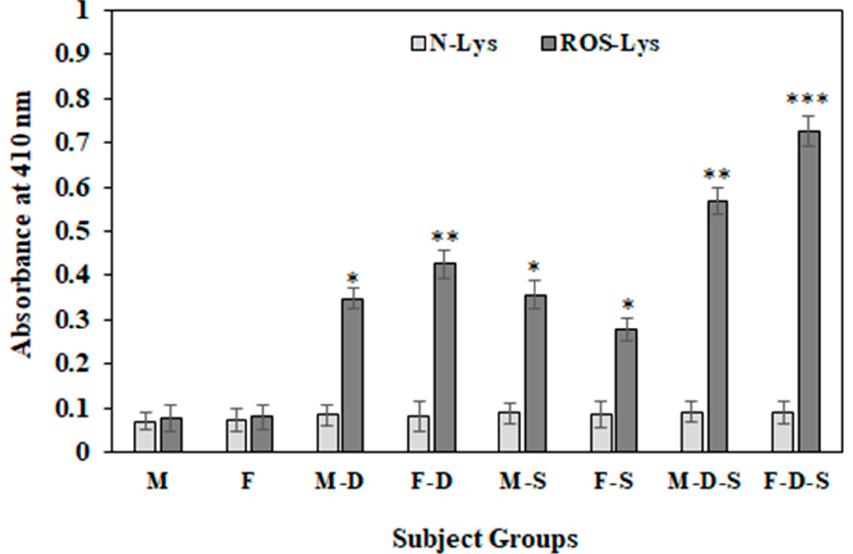
Figure 3. Detection of serum autoantibodies against native and ROS-BSA using direct binding ELISA. ELISA plates were coated with 5 µ g/mL antigens. Each group consisted of 15 subjects. Values are given as mean ± SD. The t test was adopted for comparison between the two groups, and significance is defined as * p < 0.05, ** p < 0.01, *** p < 0.001. The comparison of autoantibodies against ROS-BSA between group M with groups M-D, M-S and M-D-S showed p values < 0.01, <0.05 and <0.001, respectively. The comparison of autoantibodies against ROS-BSA between group F and groups F-D, F-S and F-D-S showed p values < 0.01, <0.05 and <0.001, respectively. No significance was observed among the groups for native BSA.